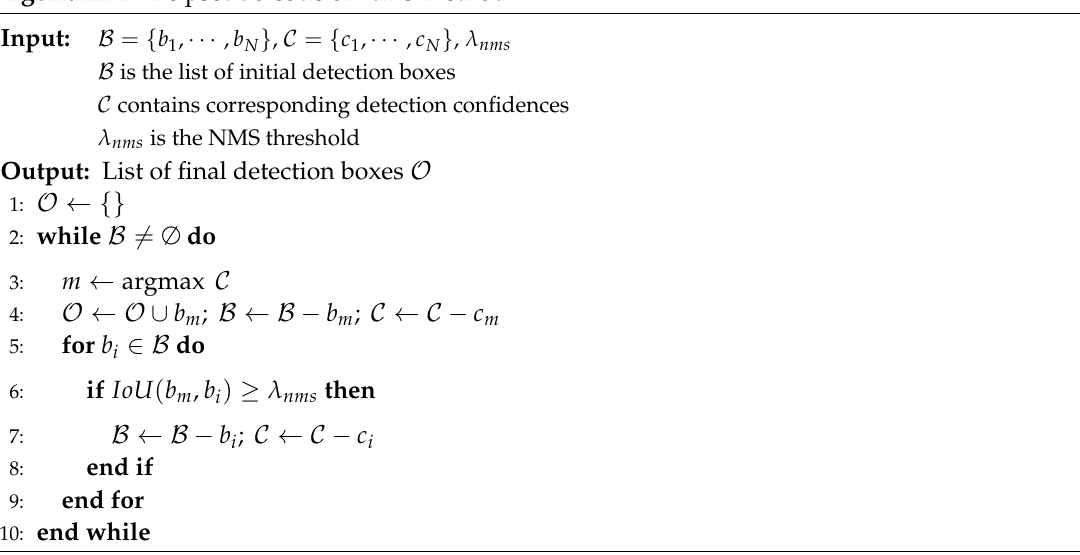
Algorithm 1 The pseudo code of NMS method